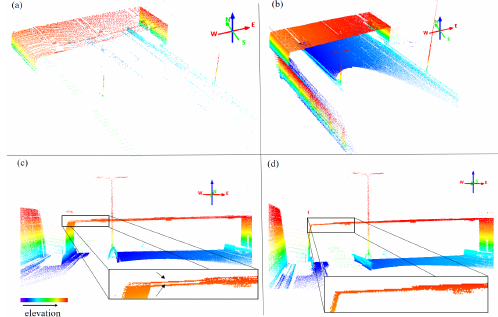
Figure 19. Differences between the translations resulted from the registration and the sub-pixel accuracy method of images with low resolution and the translations resulted from the registration of images with high resolution